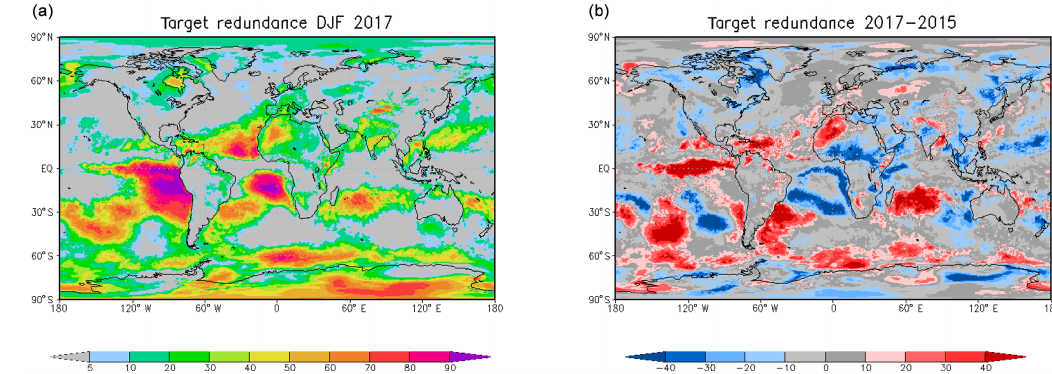
Figure 5. As in Fig. 4 but for target redundances of ECMWF lead day 4 dynamic forecasts and damped lag day − 4 persistence forecasts for the winter of 2016–2017 (a) . Differences in the target redundances between the winters of 2016–2017 and 2014–2015 (b)